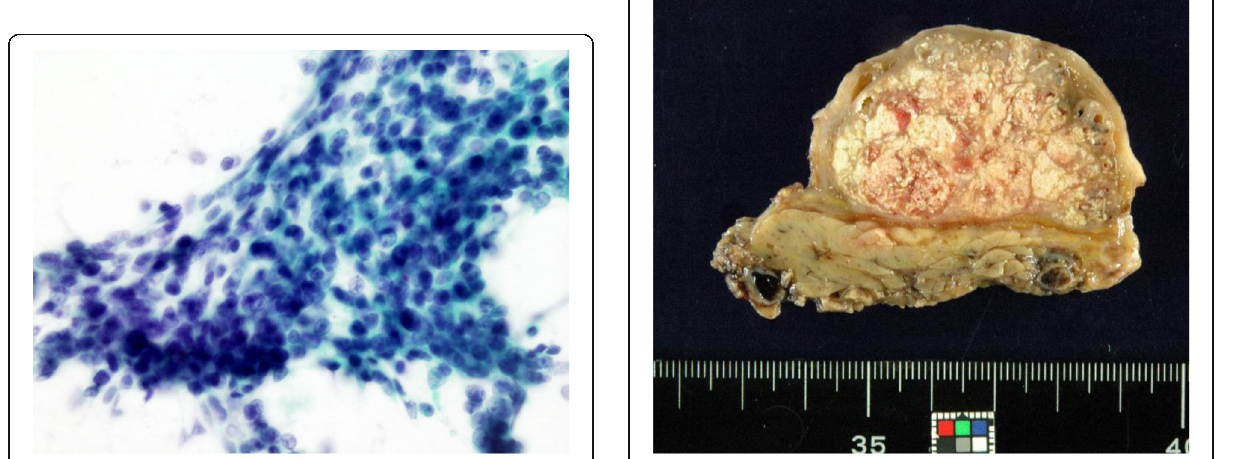
Fig. 1 Fine-needle aspiration (FNA) cytology of the left parotid region. A cluster of epithelial cells was observed (Papanicolaou staining, × 400)